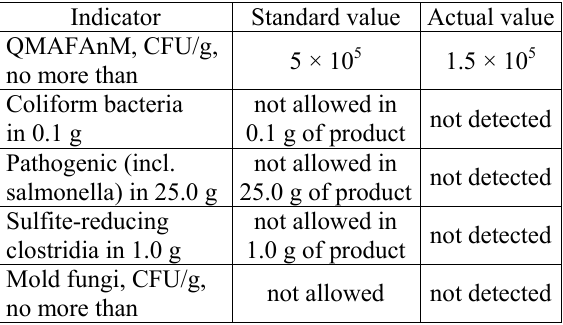
Table 4. Toxicological safety indicators of dried